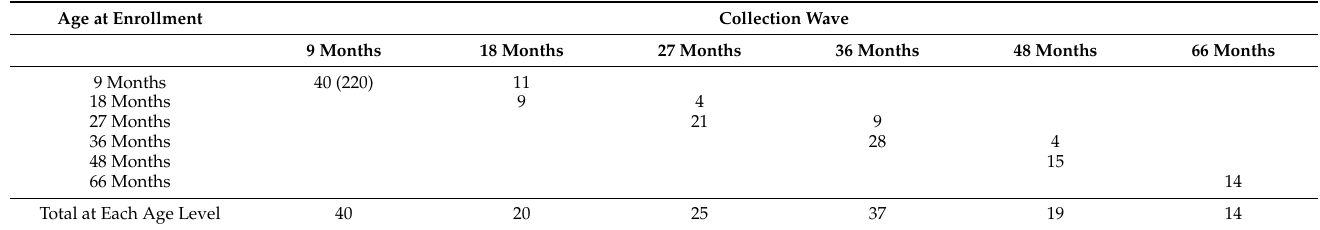
Table 1. Expected participation of children ( n = 126/ n (estimated) =